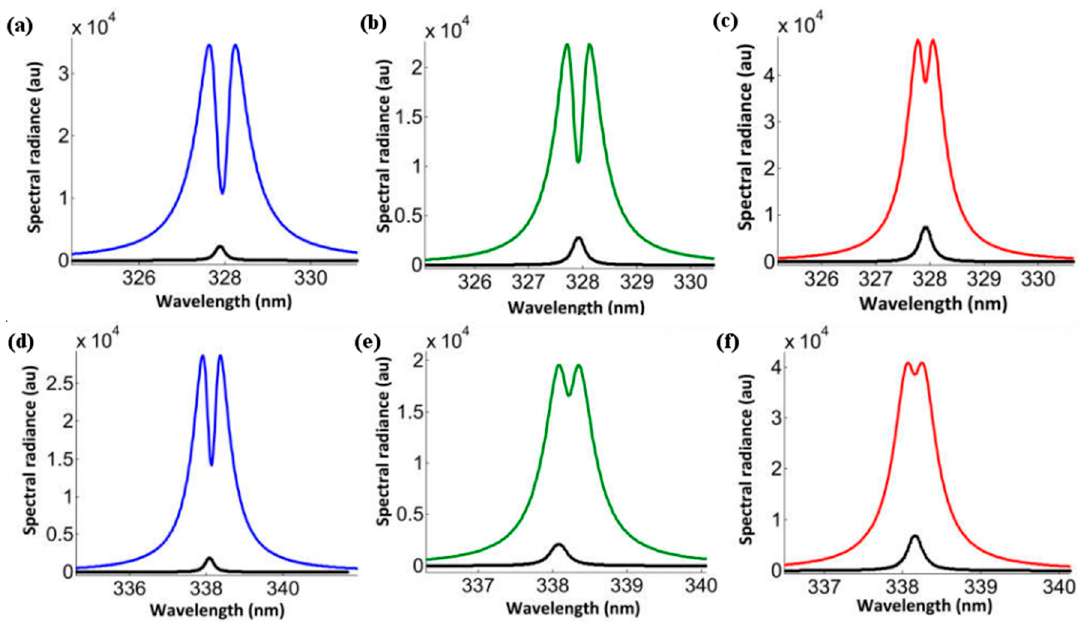
Figure 2. The effect of self-reversal on the resonance Ag I transition from nano-silver plasmas with respect to bulk target (black). Different laser irradiation wavelengths are indicated by different colors. ( a , d ) blue for 355 nm, ( b , e ) green for 532 nm, and ( c , f ) red for 1064 nm.